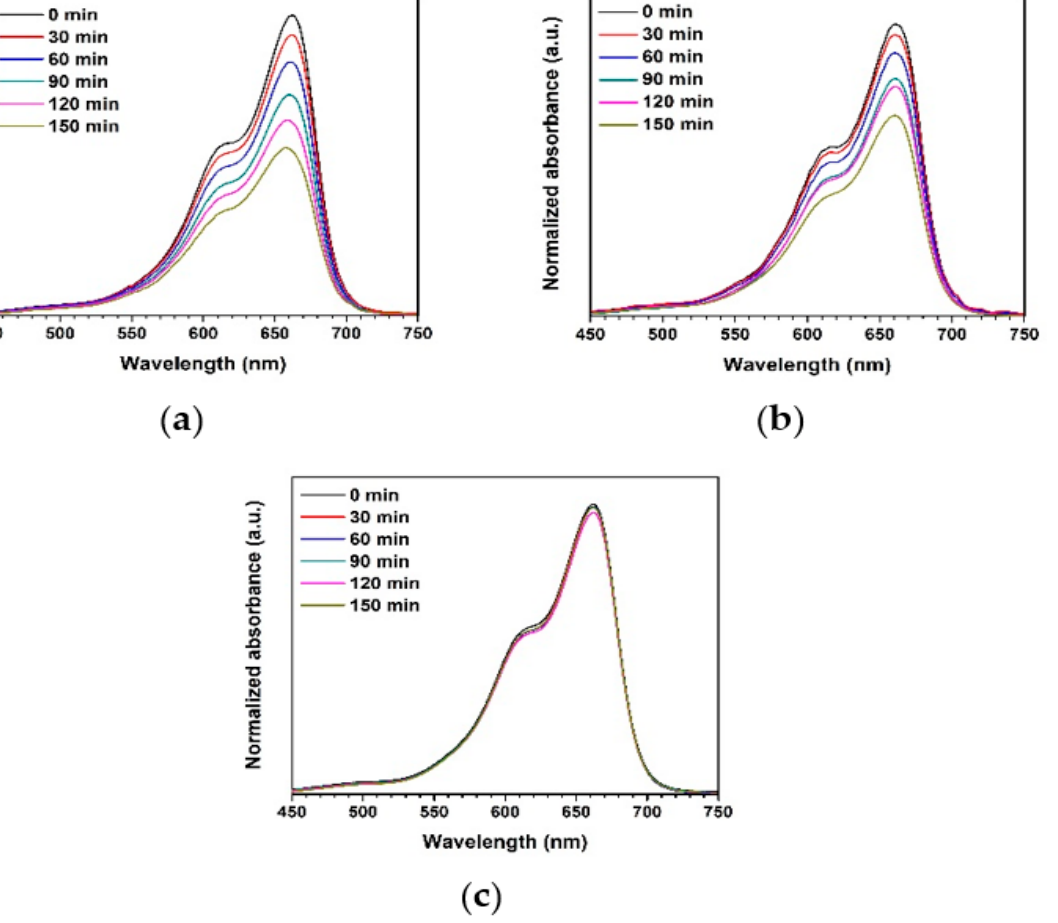
Figure 9. Normalized absorbance of MB solution under UV light using different photocatalysts: ( a ) ZnO precipitation, ( b ) ZnO combustion, and ( c ) blank. As shown in Figure 10a, the interval to the initial absorbance (A/A 0 ) ratio of MB was plotted to observe the change in MB after photocatalytic activity. When compared to ZnO combustion, the A/A 0 of MB had a significantly lower value for ZnO precipitation. For a better comparison, the apparent degradation rate constant (k app ) was analyzed using Equation (3) [9,28]: where t is the irradiation time. The k app was estimated from the slope of Figure 10b and listed in Table 1. The ZnO precipitation showed higher k app values for the photocatalytic degradation of MB than for that of the ZnO combustion around 1.6 times. The result corresponds with the larger crystal sizes of the ZnO precipitation compared to those of the ZnO